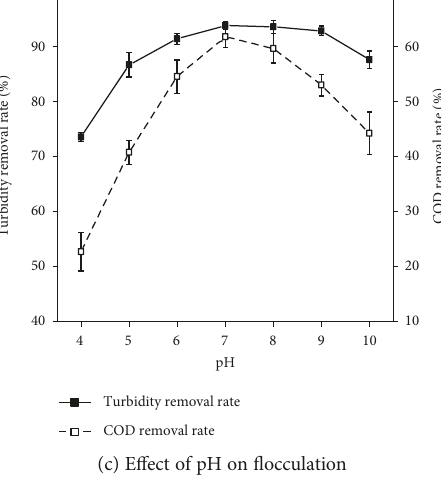
Figure 7: E ff ect of PAC & PAM on fl occulation